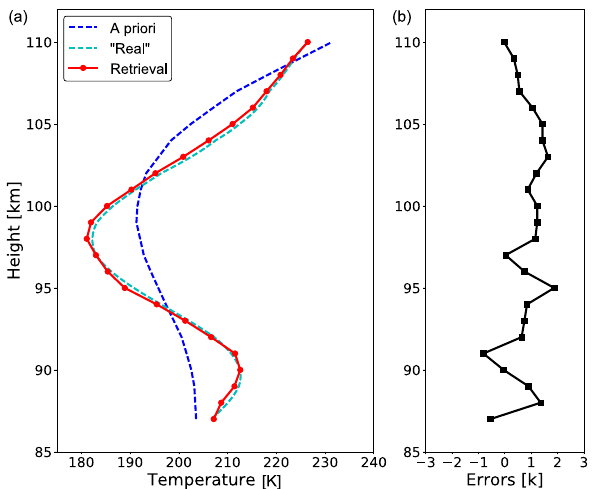
Figure 7. Vertical profile of retrieved temperature (a) and total de- viation from the expected profile including all error sources (b)